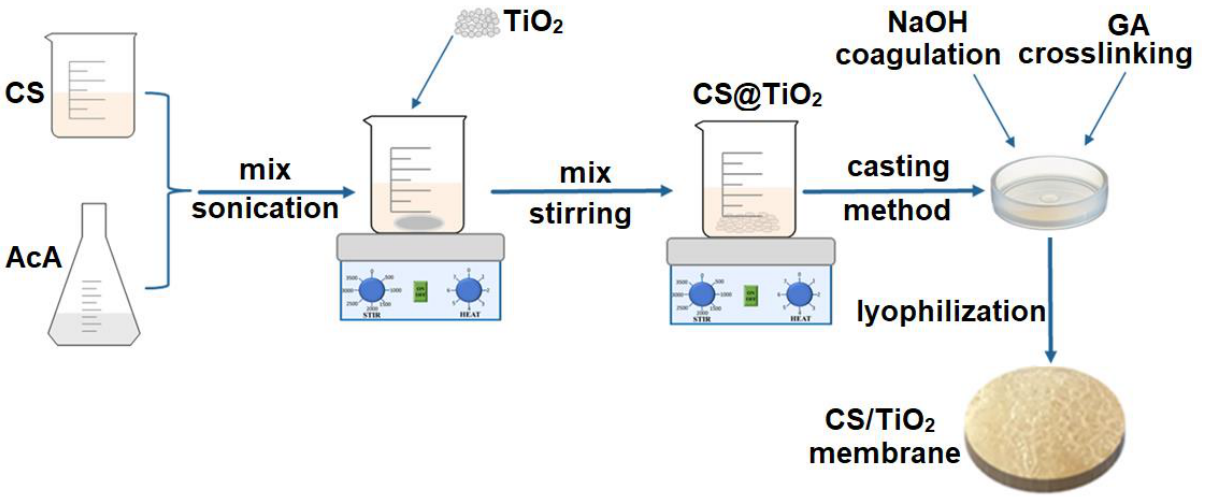
(CS—chitosan; AcA—acetic acid; Figure 1. Schematic representation of the preparation of chitosan/TiO 2 composite membranes (CS – chitosan; AcA – acetic acid; GA – glutaraldehyde).